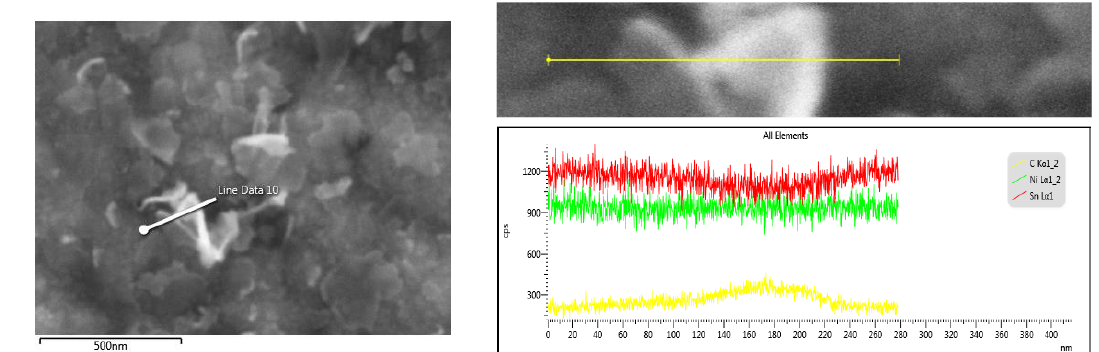
Figure 7. Energy dispersive X-ray (EDX) line scan on the composite NiSn-rGO-P3.3.